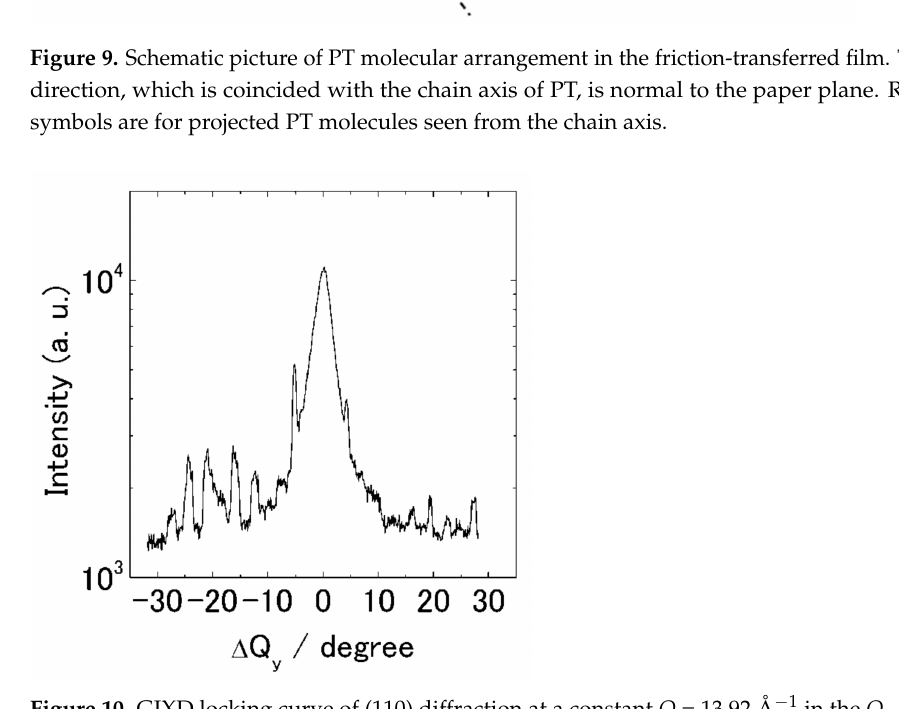
Figure 10. GIXD locking curve of (110) diffraction at a constant Q = 13.92 Å − 1 in the Q y